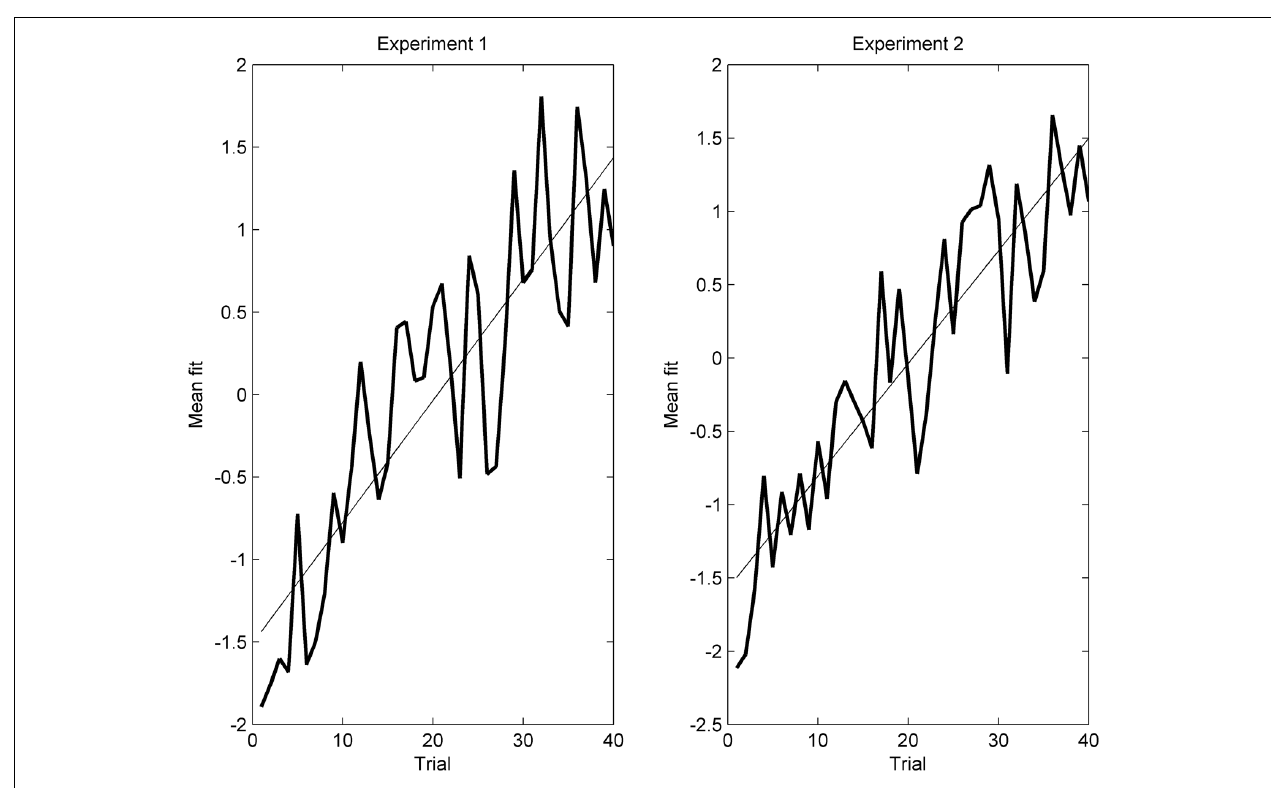
FIGURE 4 | Mean fit across all subjects of the single trial ERP (vertical axis) with the mean covariance map plotted against trial number (horizontal axis). The more positive the value, the more the single trial ERP